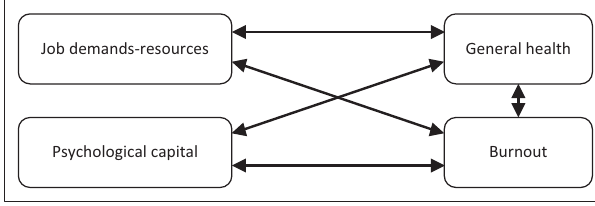
FIG URE 1: Theoretical relationship between job demands-resources, psychological capital, general health and